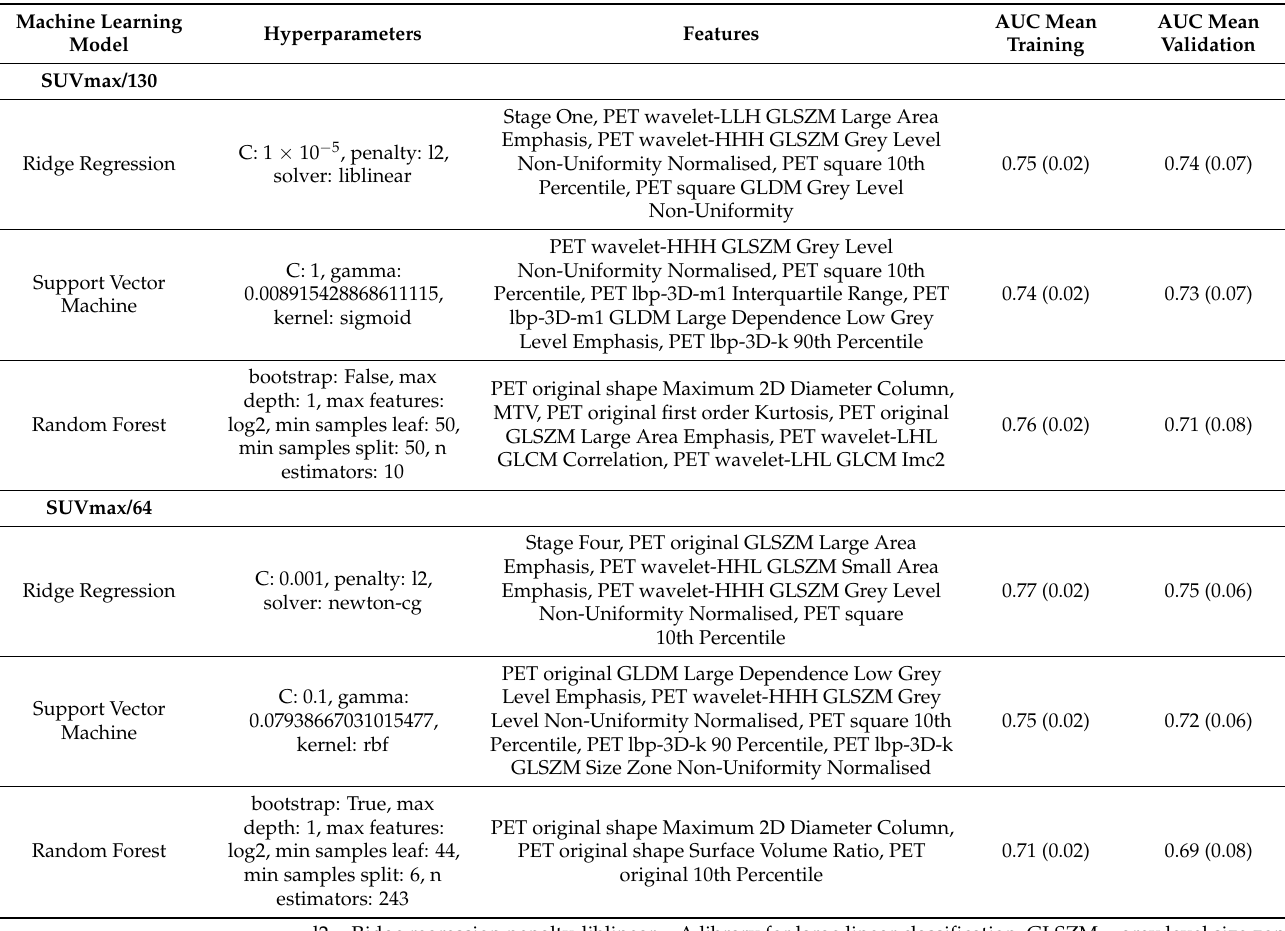
Table 3. Mean training and validation scores for the best performing machine learning models using the 4.0 SUV threshold segmentation